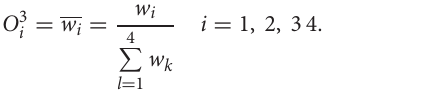
(c) Blue: 100% blue light with a wavelength of 460 nanometers (RGB = 0,0,255), (d) Red: 100% red light with a wavelength of 660 nanometers (RGB =